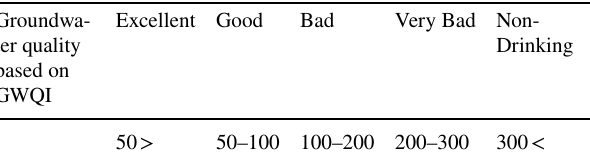
Table 5 Classification of groundwater quality for drinking based on GWQI Excellent Good Groundwa- ter quality based on GWQI